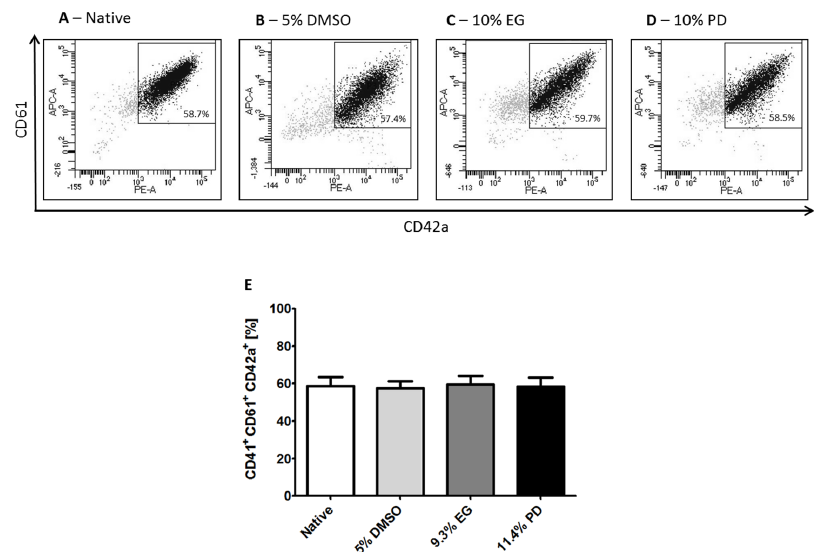
Figure 3. Frequencies of MK Population of MKs before and after cryopreservation. Differentiated MKs were identified by FSC and SSC properties and by the expression of CD41, CD42a, and CD61 markers. Representative dot plots of the flow cytometric analysis of population of MKs in the cells harvested from iPSC differentiation. Dot plots represent CD42a and CD61 double positive population gated from the CD41 positive population. Samples before ( A ) and after (( B )—5% DMSO; ( C )—10% EG; ( D )—10% PD) cryopreservation. ( E )—Percentage of triple positive MKs from the total cell population at the terminal phase of differentiation, represented as mean ± SD.